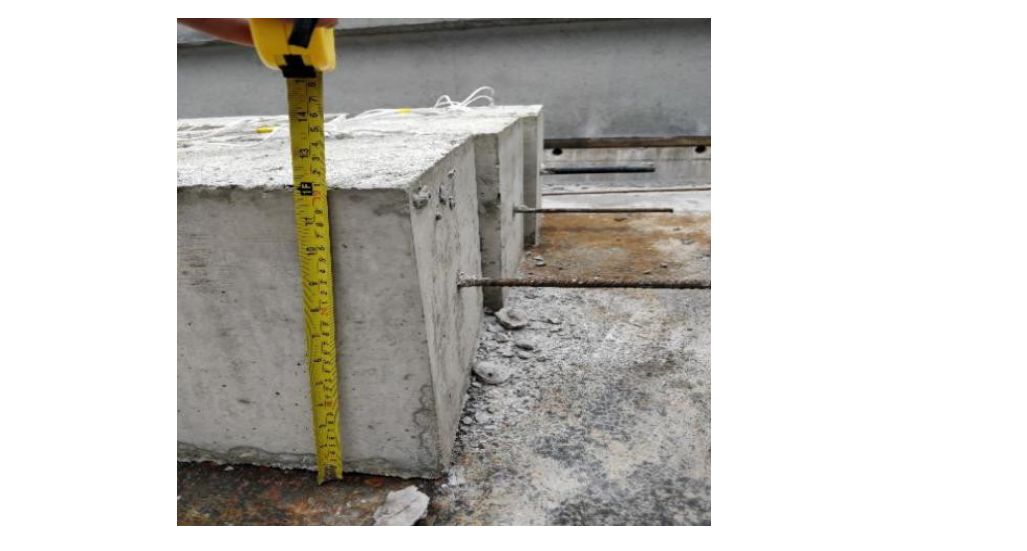
Figure 1. Reinforced concrete test specimens. Table 1. Mix proportion of C30 and C50.